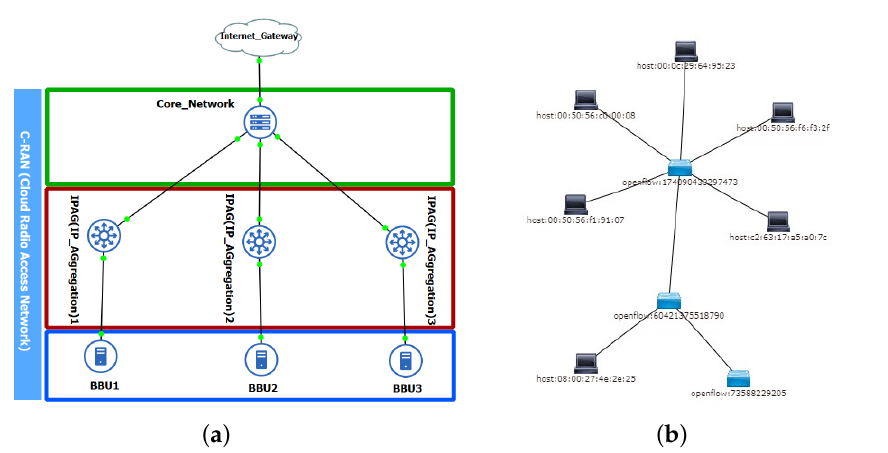
Figure 3. 5G C-RAN setup on GNS3 and WSN Network Connected to OpenDaylight SDN Controller. ( a ) 5G emulated C-RAN testbed on GNS3; ( b ) WSN and GNS3 emulated 5G C-RAN connected